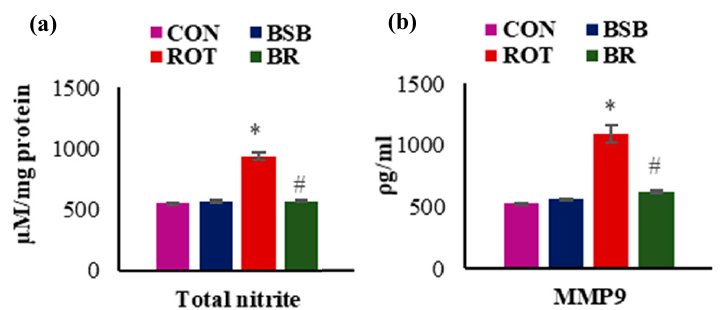
Figure 4. Change in the levels of total NO ( a ) and MMP-9 ( b ) in the mid brain following ROT administration. The levels of NO and MMP-9 was significantly increased in the ROT injected rats compared to control rats. Moreover, rats injected with ROT and treated with BSB showed significantly decreased levels of NO and MMP-9. The values are expressed as the mean ± SEM (n = 7–8). * p < 0.05 CON vs ROT; # p < 0.05 ROT vs BR (One-way ANOVA followed by Tukey’s test).